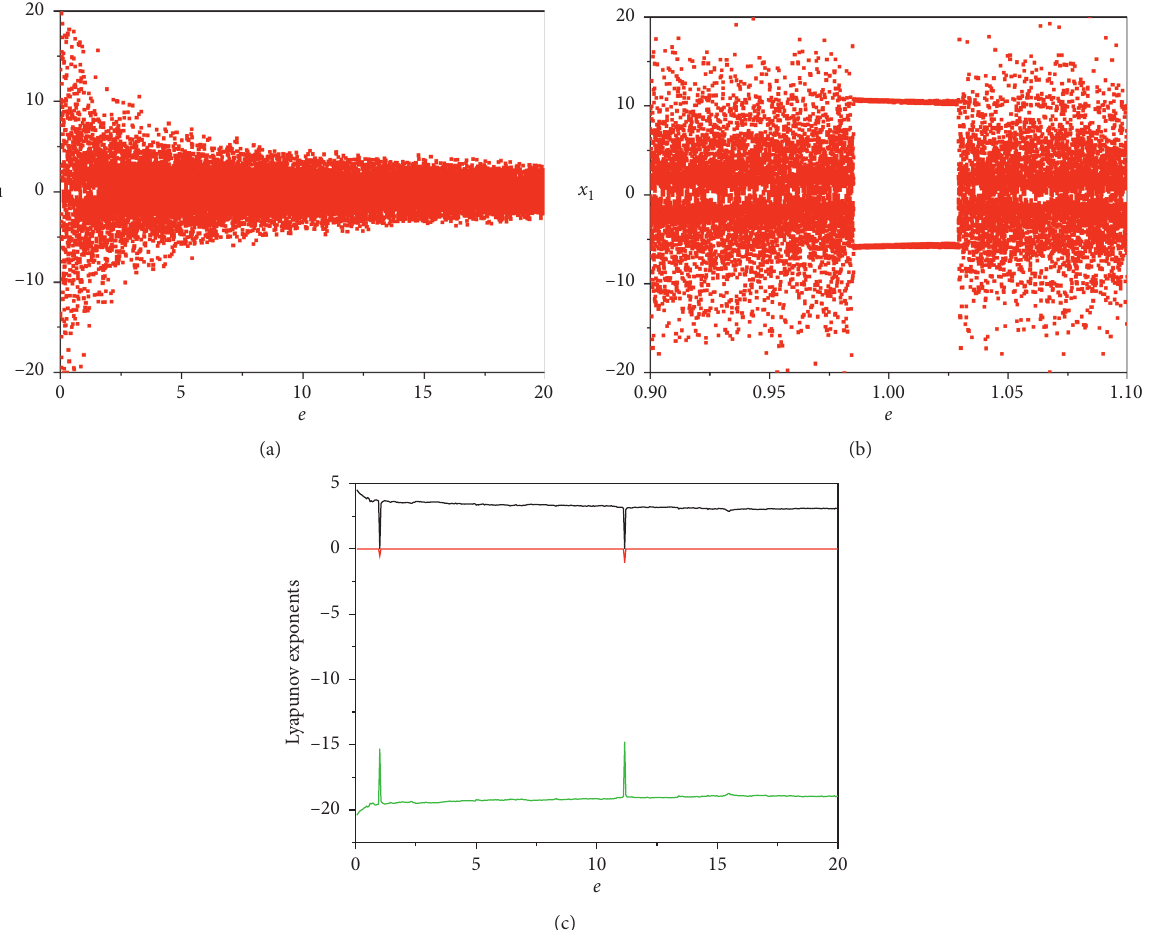
Figure 3: (a, b) Bifurcation diagram versus e ; (c) finite time Lyapunov exponent spectrum versus e